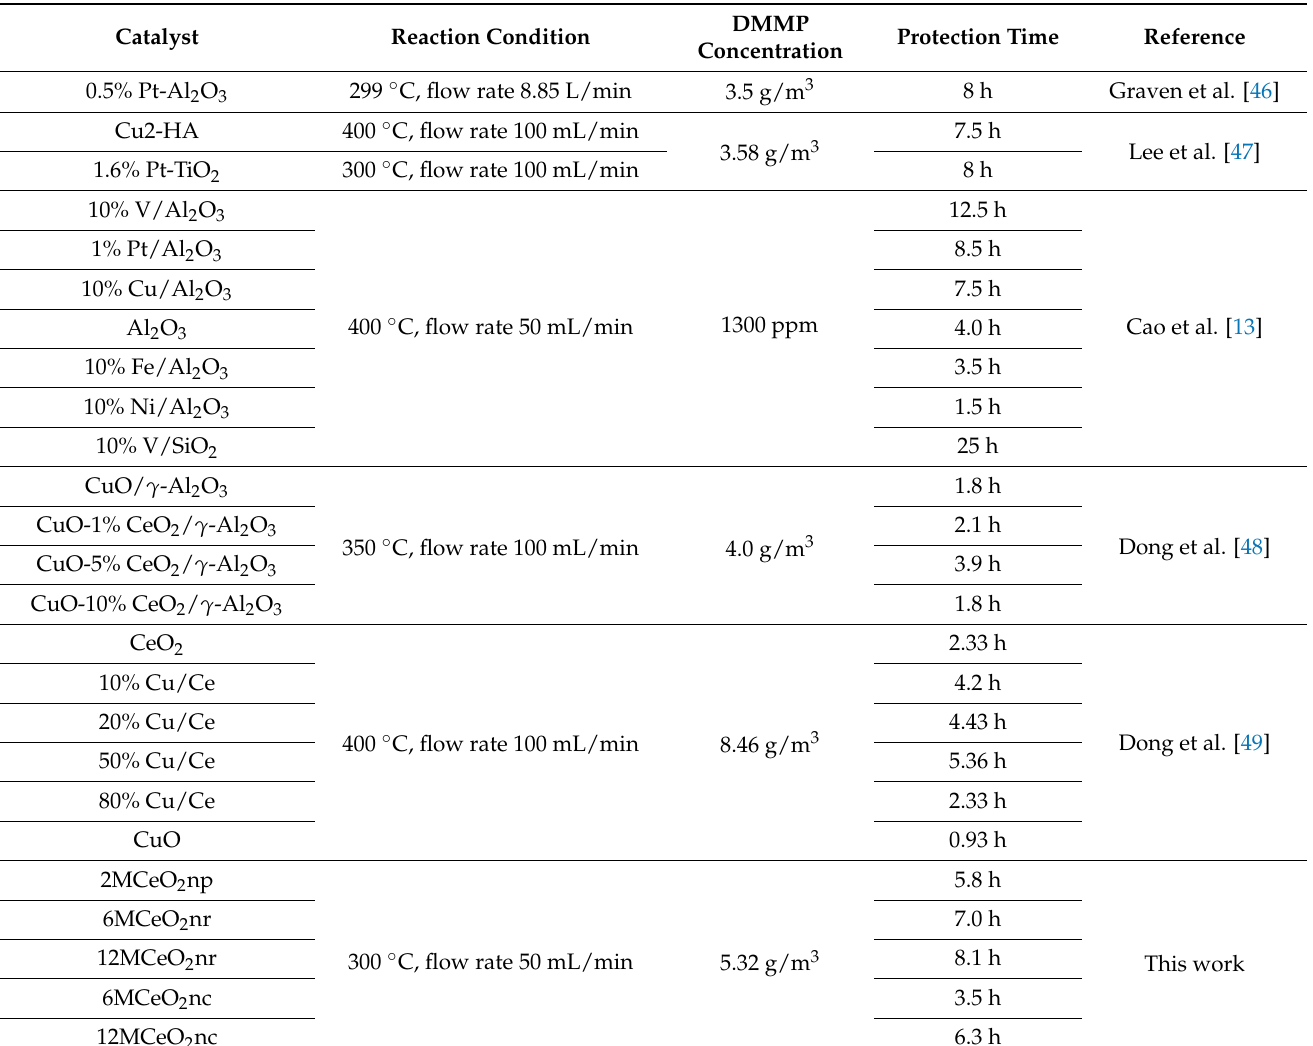
Table 3. Protection time on various